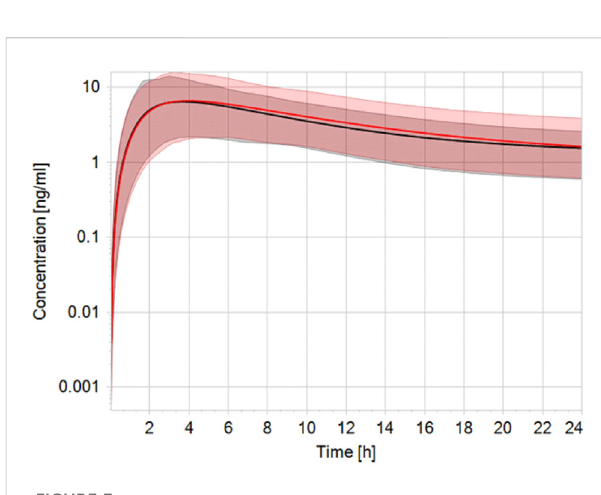
FIGURE 3 Simulated plasma CPF concentration-time pro fi le in non- pregnant (black line) vs. pregnant (red line) population ( n = 100) after a single oraldose of2 mg/kgbw. Theblack andred solidlinesrepresent predicted mean pro fi le while the shaded areas represent the predicted 95% con fi dence